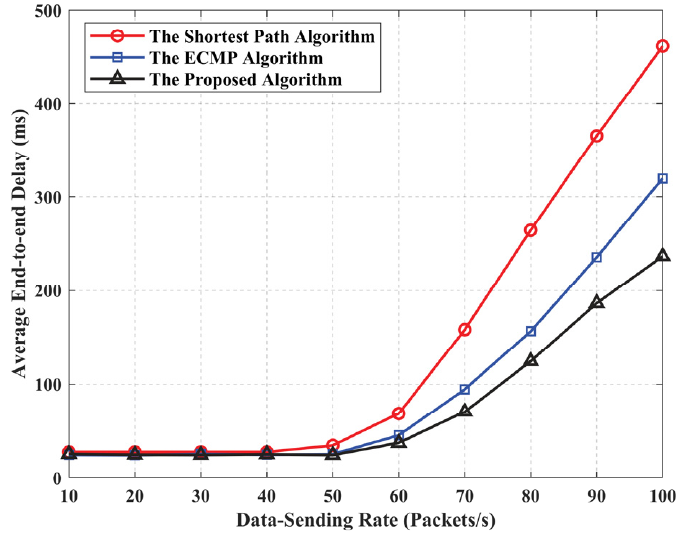
Figure 7. Average end-to-end delay at different data-sending rates.